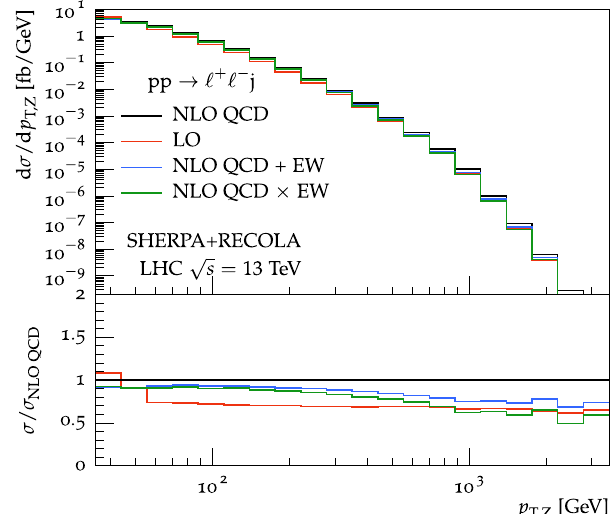
structed Z boson for off-shell Z production. The lower panels display the ratio of the distributions to the NLO QCD result